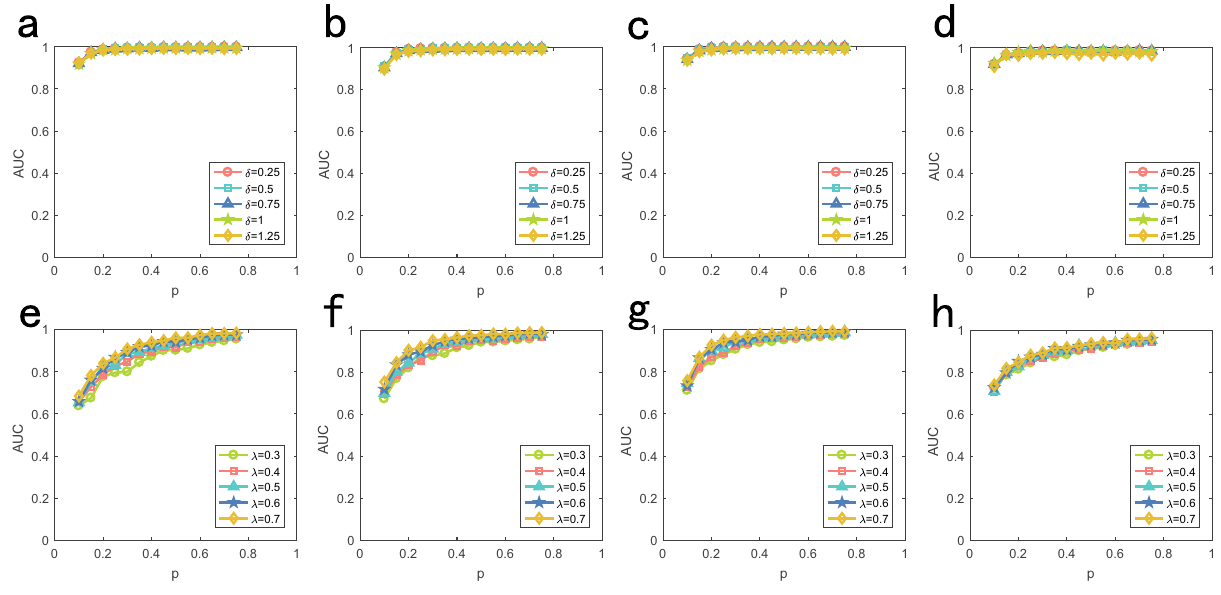
Figure 6. Performance of the multiple source location with different model propagation parameters. Abscissa is fraction of observer nodes and ordinate is AUC value. All initial time of sources are set as 0. ( a )–( d ) are diffusion dynamics on BA, ER, Football and Santa Fe respectively. Curves of different colors corresponding to different standard deviation σ with the same u = 2 of diffusion process. ( e )–( h ) are SI dynamics. Curves of different colors corresponding to different informed rate (cid:31) of SI epidemic model. parameters. We set the number of sources as 2 and all sources have identical initial time as 0. For the time delay distribution of diffusion dynamics, we set identical u = 2 and different σ = 0.25, 0.5, 0.75, 1, 1.5 . As is shown in Fig. 6, the performance of our method is not visibly affected by the parameter σ . For SI dynamics, we set different informed rate as (cid:31) = 0.3, 0.4, 0.5, 0.6, 0.7 . As is shown, the performance of our method decrease with the decrease of (cid:31) . Because low informed rate lead to more disordered informed time of nodes. Clearly, for all different σ of diffusion dynamics, only approximately 10% observer nodes can receive relatively high accuracy AUC > 0.8 , and AUC > 0.6 for different (cid:31) of SI dynamics. To sum up, the performance of our algorithm indicate relative high robustness.